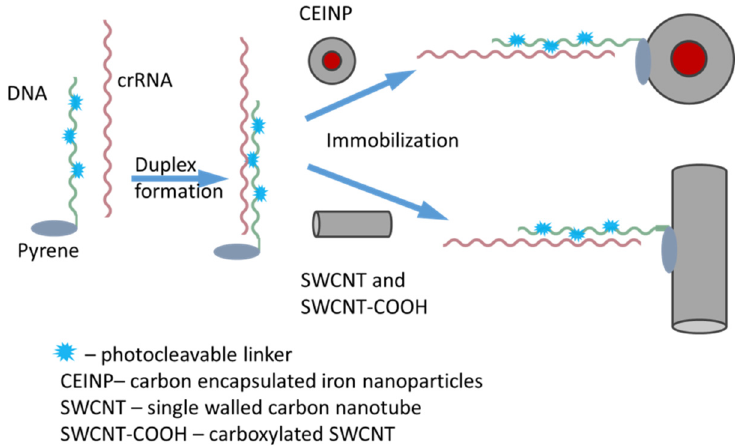
Figure 3. Scheme of the crRNA immobilization on the surface of carbon nanoparticles using auxiliary 3’-pyrene DNA conjugates.